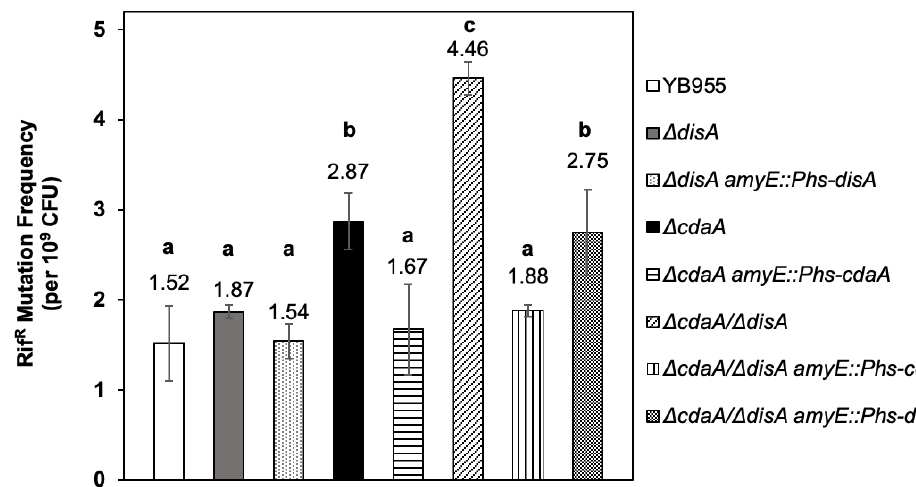
Figure 2. Spontaneous mutation frequencies to rifampicin resistance (Rif R ) of Bacillus subtilis YB955 (open bar), ∆ disA (dark grey bar), ∆ cdaA (black bar) and ∆ cdaA / ∆ disA (hatched bar) were determined during exponential growth. Complemented strains ∆ disA amyE:: P hs-disA (light stippled bar), ∆ cdaA amyE ::P hs - cdaA (horizontal stripped bar), ∆ cdaA / ∆ disA amyE:: P hs-cdaA (vertical stripped bar), and ∆ cdaA / ∆ disA amyE:: P hs-disA (dark stippled bar) were also tested. Data show the average from three independent experiments, each one in sextuplicate ± standard deviations. All strains were supplemented with IPTG 0.25 mM. Different letters (a, b, c) represent significant statistical differences between means; the same letter denotes no significant difference, as determined by a one-way ANOVA and multiple mean comparison by Tukey HSD test (all p -values < 0.001).